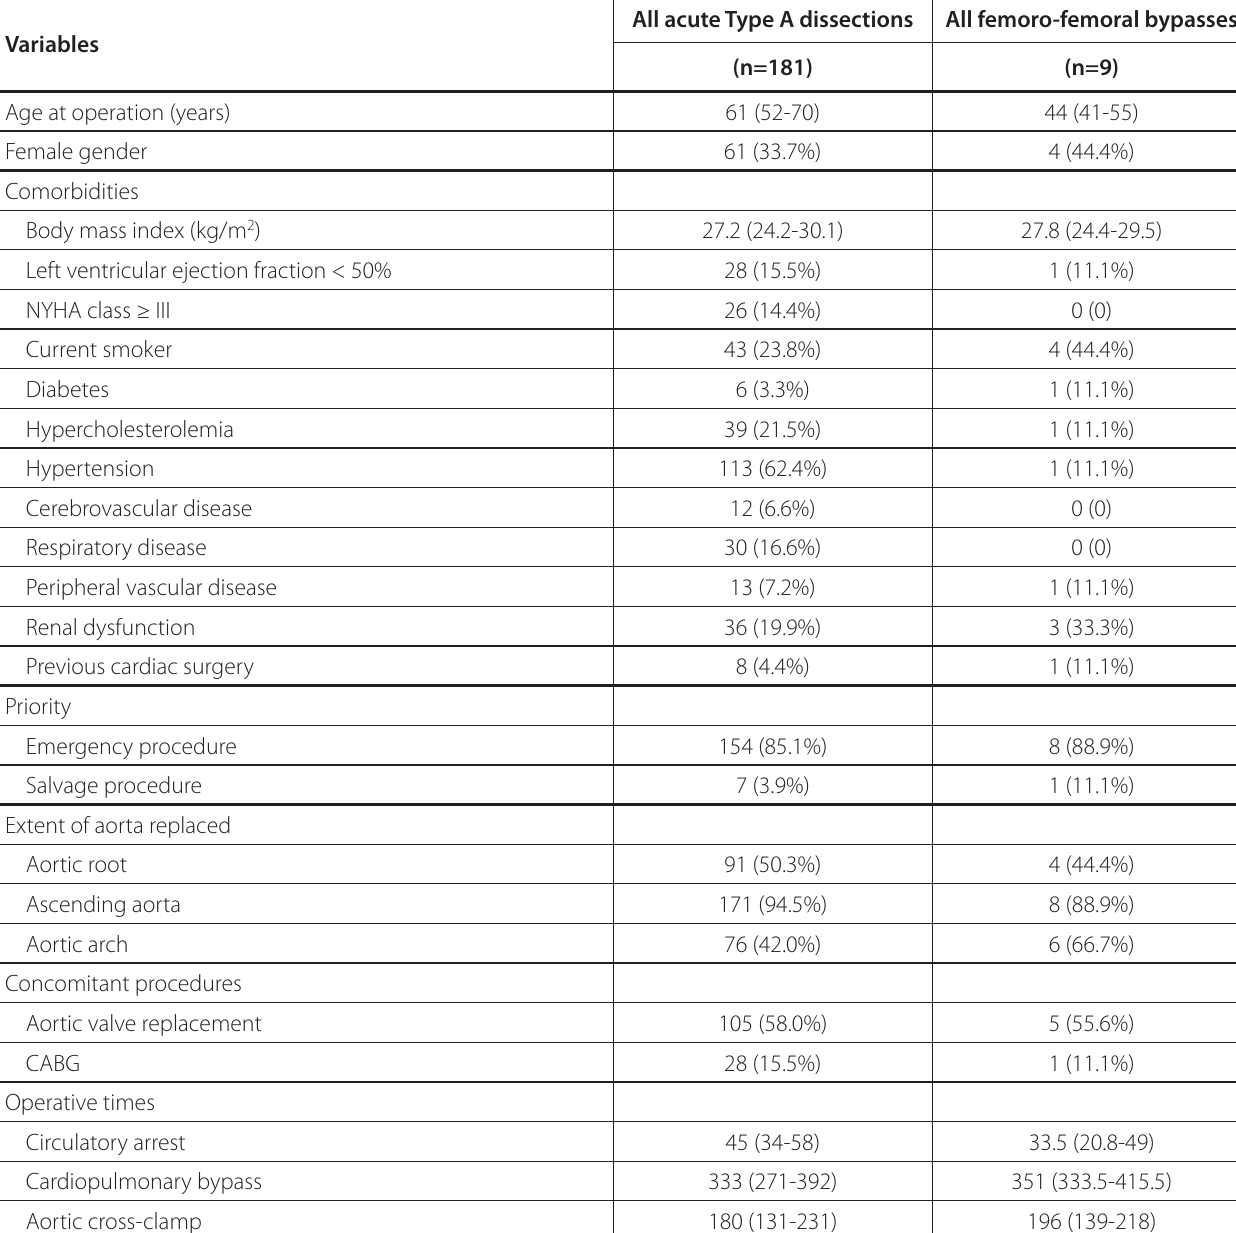
Table 2 . Patients’ demographics, co-morbidities, and operative details.